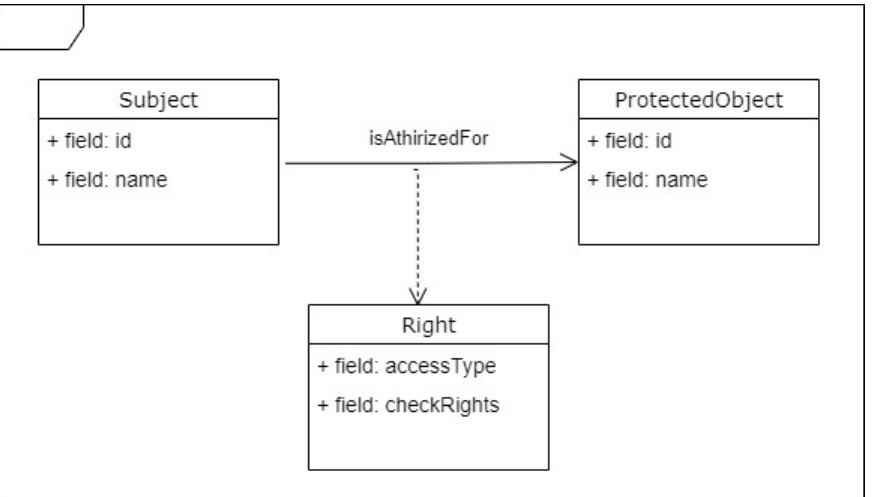
Figure 13. Essential components of Authorization Enforcer pattern—class diagram [14].